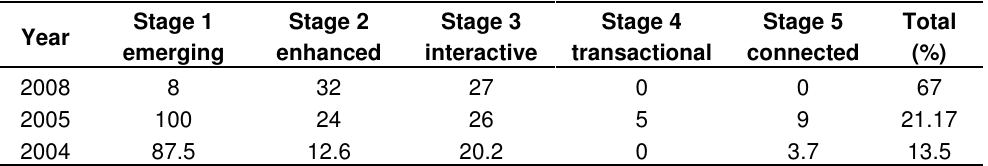
Table 4. Nigeria (Service delivery by stages (percent